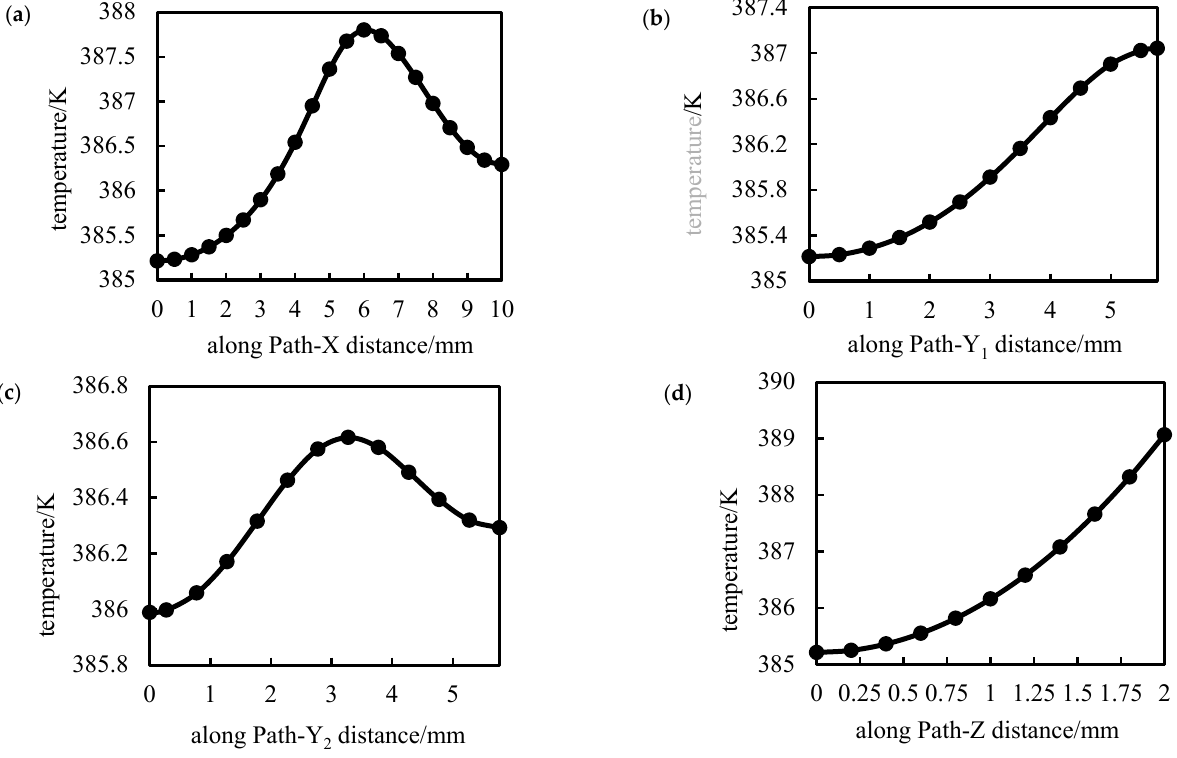
Figure 16. Temperature distribution along each path of performance-optimized multi-axial geogrid. ( a ) Path-X, ( b ) Path-Y 1 , ( c ) Path-Y 2 , ( d ) Path-Z. As seen in Figure 16, along paths X and Y 2 , the temperature change trend is similar, first increasing and then decreasing, along paths Y 1 and Z, the temperature increases with the distance. Combined with the simulation results in Figure 15, the temperature is related to the distance from the adoption point to the semicircular hole, and the temperature is the highest at the semicircular hole. The temperature between the edge core and the core of the model is lower. By comparing the above figures, it is found that the heat transfer temperature of the region forming nodes in the subsequent stretching process is lower after completion, and the heat transfer temperature of the region forming ribs is higher. 4.3. Tensile Forming Simulation of Performance Optimized Multi-Axial Geogrid In this section, the tensile forming simulation of POMG is carried out. The simulated basic unit shown in Figure 14 is stretched longitudinally and laterally in turn, setting two “power, temperature-displacement, explicit” analysis steps, step-1 and Step-2, which respectively represent the longitudinal and transverse stretching processes, and impose boundary conditions on the partial loading surface shown in Figure 14. In the initial step, the model is set to be symmetrical and specular symmetry, the boundary condition is inherited to the next step, and the heat transfer result file is imported as a predefined field. In step-1, the model is set to be symmetrical and the load is applied to the plane so that the longitudinal displacement is 11.6 mm. In step-2, the boundary condition set in Step-1 is deactivated, and the model is set to be symmetrical, and the load is applied to the plane so that the lateral displacement is 20 mm. In this way, the stretch forming process of POMG can be simulated according to the process conditions in Table 1. After the load and boundary conditions are set, an eight-node thermal coupled hexahedral element C3D8T was used for meshing. The mesh size was 0.1 mm, and each mesh should be consistent with the heat transfer step. The results are as follows. 4.3.1. Overall Shape Analysis Figure 17 shows the strain distribution obtained from the simulation of the stretch forming process of POMG with circular and semicircular pre-punched holes.